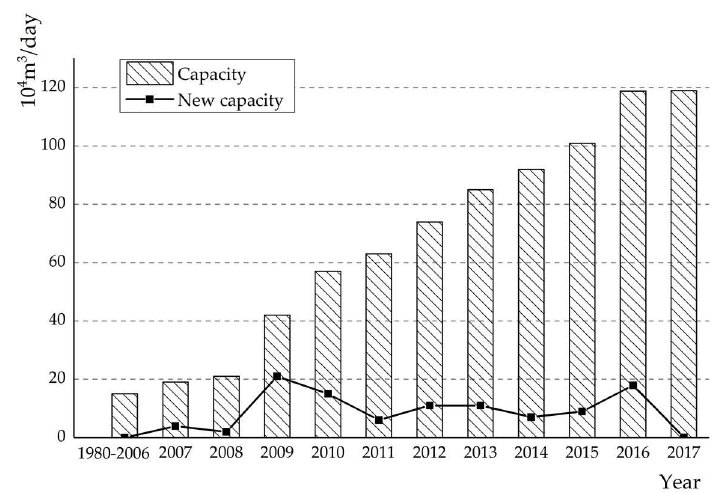
Figure 2. Changes in the capacity of Chinese desalination projects from 1980 to 2017.Data Source: Desalination Branch of China Water Enterprises Confederation, “China Desalination Yearbook 2016–